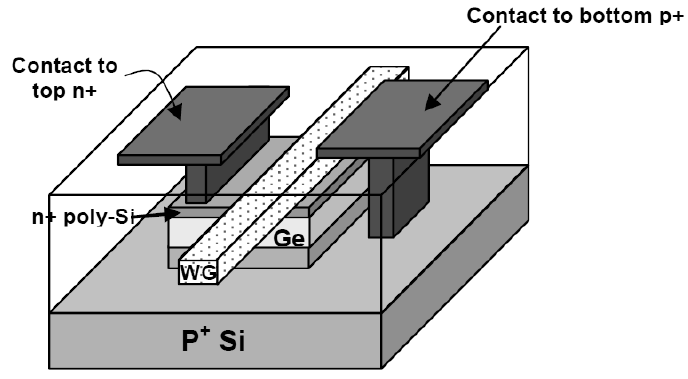
Figure 13. Schematic structure of a waveguide-integrated Ge p-i-n photodetector